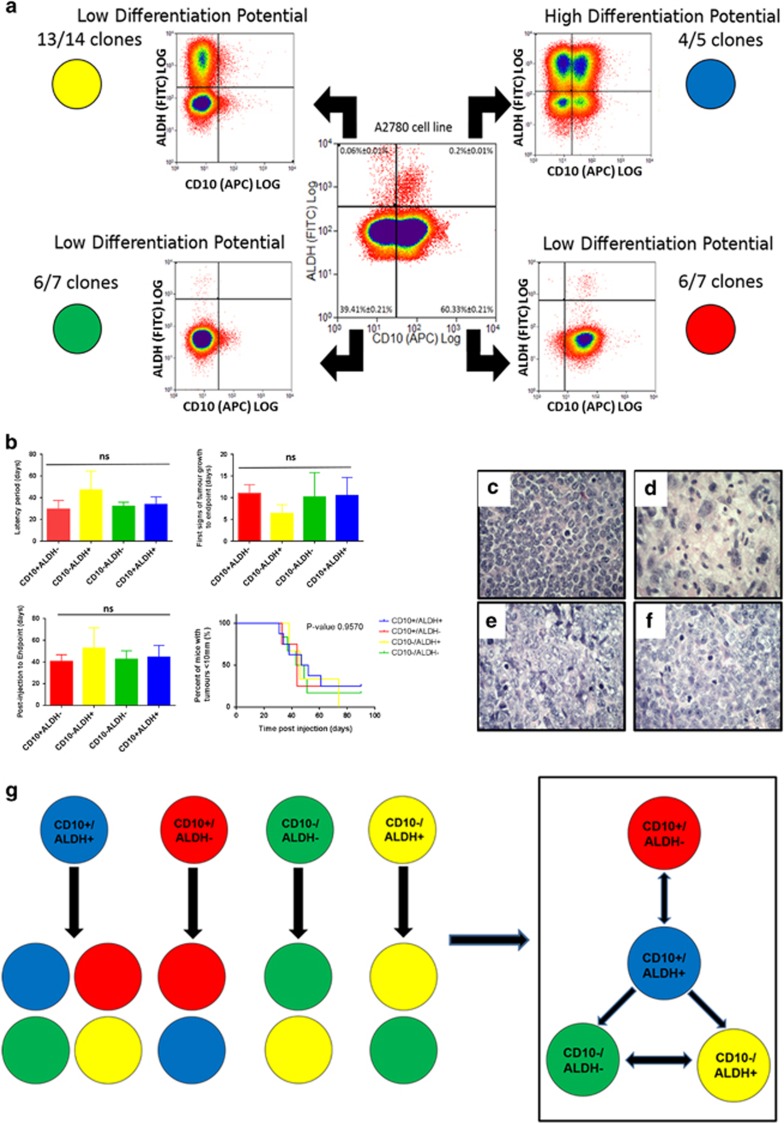
CD10+/ALDH+ is the apex component of a novel ovCSC network. CD10 was identified as an ALDH−A marker as described in Supplementary Data 2, resulting in identification of four putative CSC populations via flow cytometry (CD10+/ALDH+, CD10−/ALDH−, CD10+/ALDH−, CD10−/ALDH+: a, centre). Each of the four populations was similarly capable (no significant (NS) difference in latency period, first sight of tumour growth, time from injection to end point or percentage of mice generating tumours) of generating xenograft tumours from as little as 90 cells, validating them as true CSCs (b; Population mean comparison using analysis of variance test. Data shown are mean±S.D. of n⩾3 mice). Histological analysis demonstrated an ovarian cancer-like pathology (c: CD10−/ALDH−, d: CD10+/ALDH−, e: CD10−/ALDH+, f: CD10+/ALDH+), with no consistent differences between the populations. All four populations were plated as single cells and assessed for their relationship to one another via SCAD assay (a). (g) This analysis was summarised and modelled and identified CD10+/ALDH+ as the most potent, apex CSC. Unusually, this apex CSC could be produced by less potent CD10−/ALDH+ CSCs. The two additional low-potency CSCs were capable of producing one another. Rather than the standard hierarchical, tree structure, this novel CD10/ALDH model is apparently a CSC Network